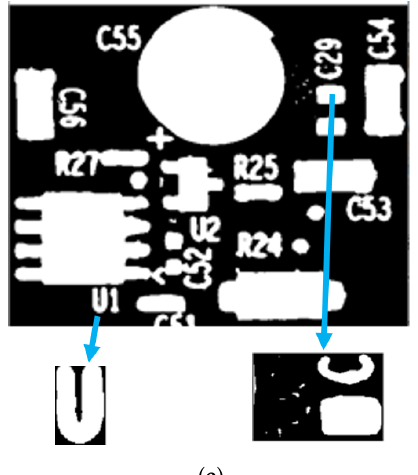
Figure 3. Automatic detection of local windows to refine the background. ( a ) Input color image. ( b ) Global thresholded image. Global hue range: (75, 90). Global saturation range: (111, 255). ( c ) Relevant blobs and selected regions before applying local thresholding ( d ). Relevant corresponding image regions. ( e ) Refined background after global and local thresholding. Local hue and saturation ranges of the two selected subregions: (75, 80), (102, 234) and (70, 95), (101, 252),